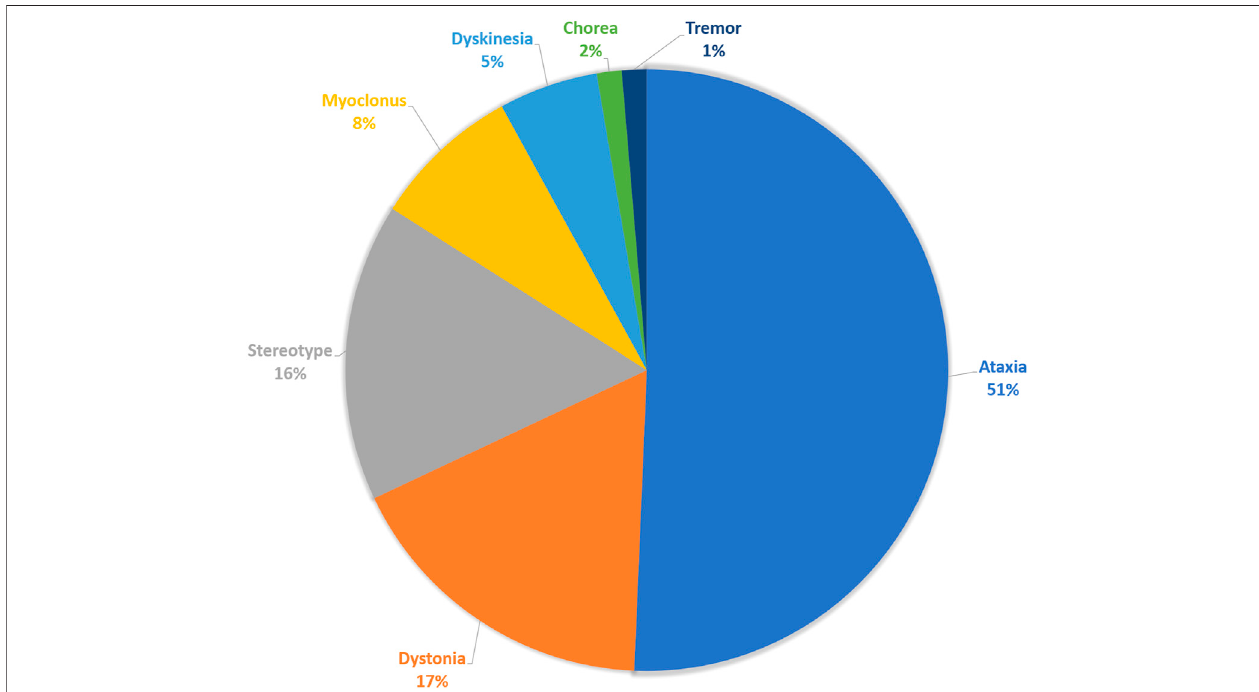
FIGURE 1 | Movement phenomenology. The composition of main movement phenomena of the enrolled